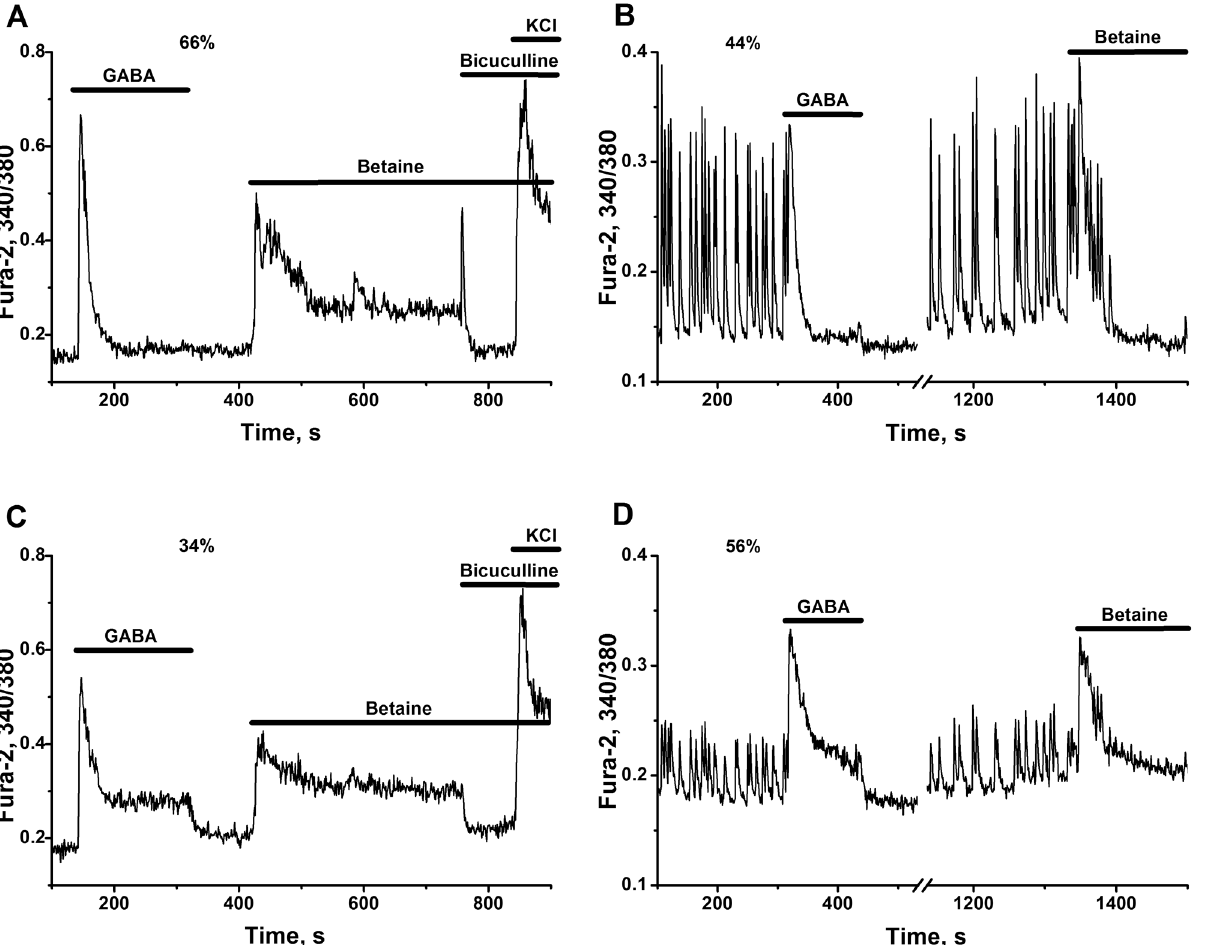
Fig 12. Similarity of the action of GABA and betaine on Ca 2+ -signaling in immature cells. Cultures 5, 7 DIV. The records of representative cells (to 60% of the cells on Fig A) and to 50% on Fig B). All other abbreviations and descriptions as on Fig 2. (A, C) Two types of Ca 2+ responses to the application of GABA (5 μ M) and one type of response to the action of betaine (10 mM) and suppression of betaine effect by bicuculline (2 μ M) are observed in culture 5 DIV. N = 74. n = 3. (B, D) Inhibition of spontaneous Ca 2+ -oscillations in individual cells, observed in culture 7 DIV after addition of GABA and betaine. Two types of Ca 2+ response to GABA and one type of response to betaine are observed in 20% of cultures in the cells with spontaneous activity. N = 36. n = 10. Here presented only parts of total records (Fig B, D). Initial parts were omitted for